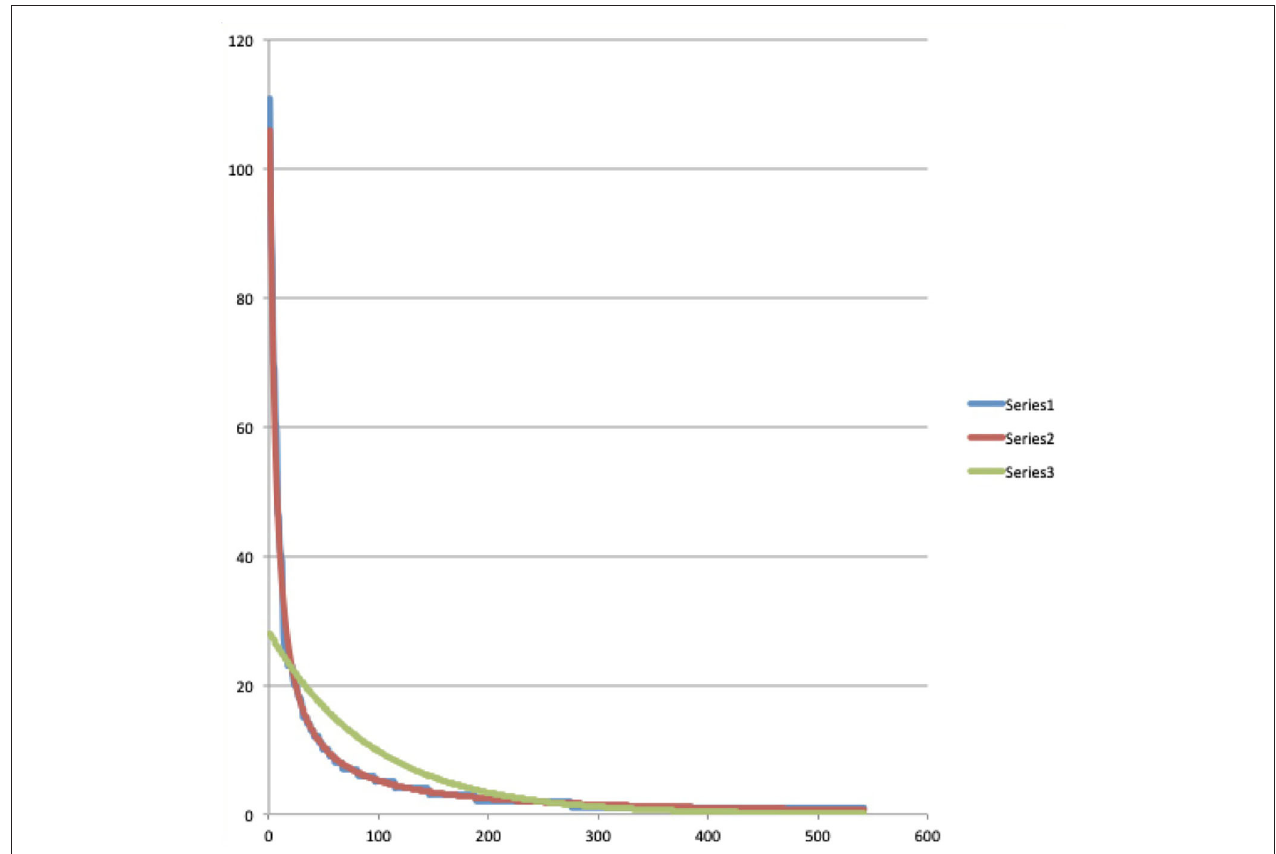
FIGURE 2 | A representation of the “number of appearances” of words in the Winnie the Pooh story “In Which Piglet Meets a Haffalump” (Milne, 1926), ranked from lowest energy level, corresponding to the most often appearing word, to highest energy level, corresponding to the least often appearing word as listed in Table 1 . The blue graph (Series 1) represents the data, i.e., the collected numbers of appearances from the story (column “ N ( E i )” of Table 1 ), the red graph (Series 2) is a Bose-Einstein distribution model for these numbers of appearances (column “B-E mod” of Table 1 ), and the green graph (Series 3) is a Maxwell-Boltzmann distribution model (column “M-B mod” of Table 1